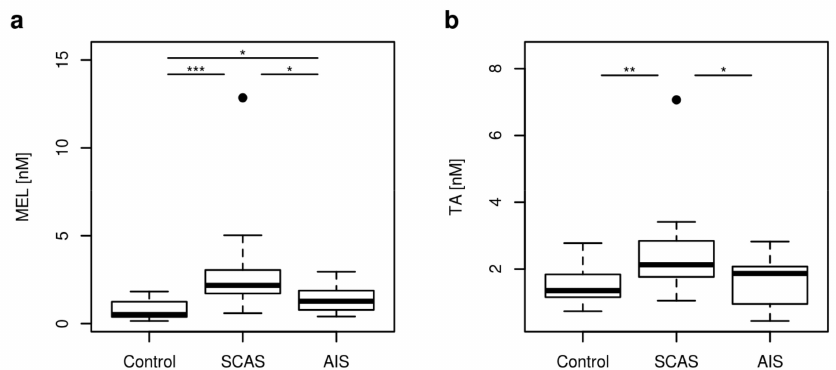
Figure 4. The boxplots of non KP metabolites concentrations changed in neurovascular disease. ( a ) MEL: melatonin; ( b ) TA: tryptamine. Significance codes for post-hoc Dunn test: *** p < 0.001, ** p < 0.01, * p <